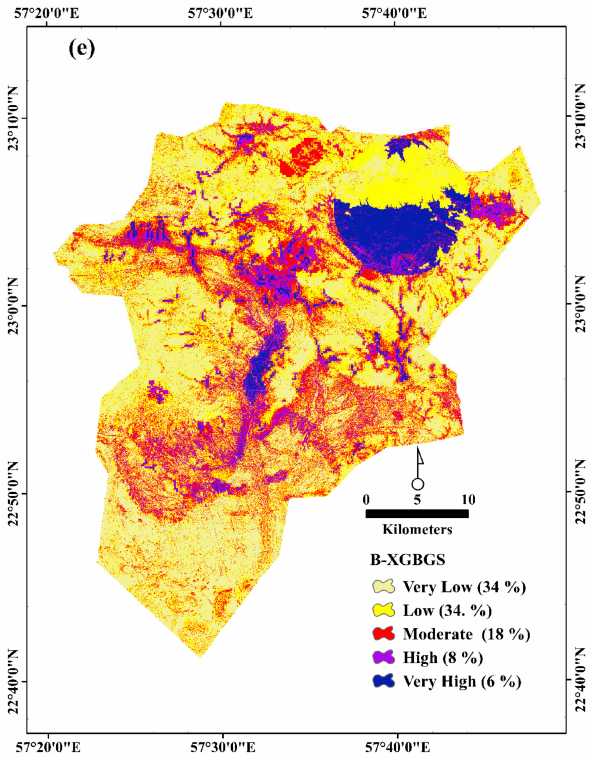
Figure 8. Map of groundwater potential in the Nizwa watersheds based on five machine learning algroithms: ( a ) SVM, ( b ) Xgboost, ( c ) Rs-Xgboost, ( d ) GR-Xgbosst and ( e ) Bayesian-Xgboost.